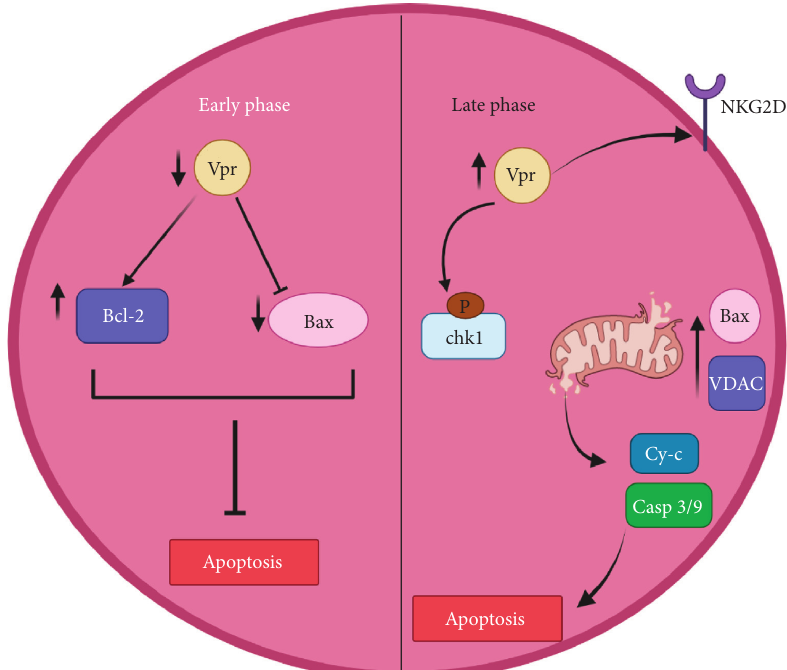
Figure 1: Antiapoptotic and proapoptotic effects of Vpr in the early and later stages of HIV